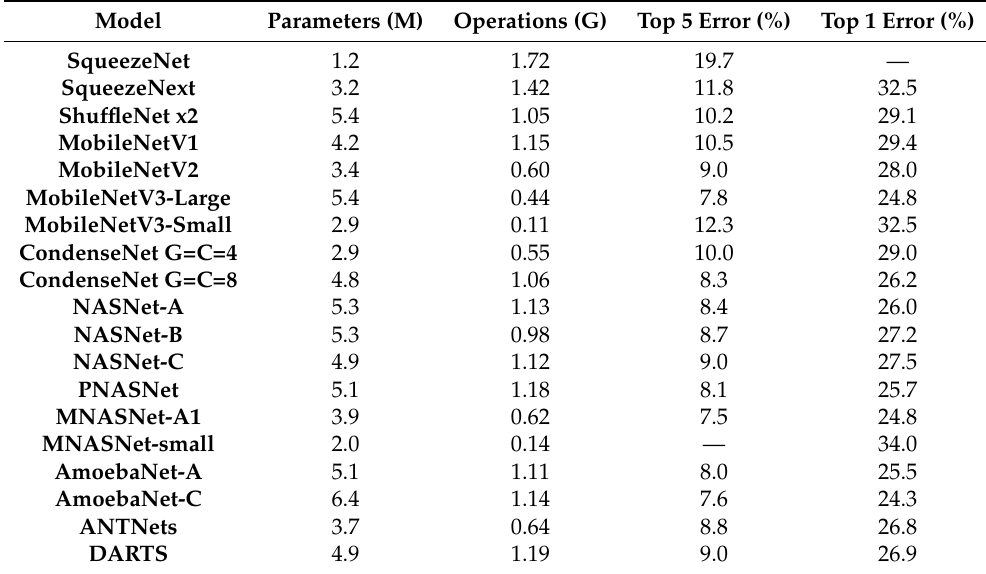
Table 3. Summary of lightweight DNN